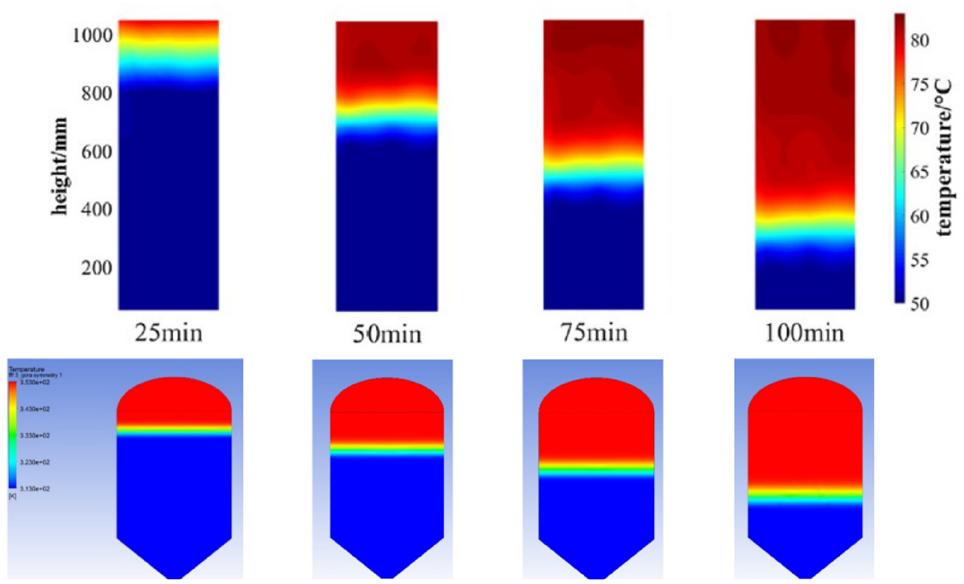
Figure 4. Temperature distribution as a function of time for the real (( top ), source: [29]) and modeled tank ( bottom ).